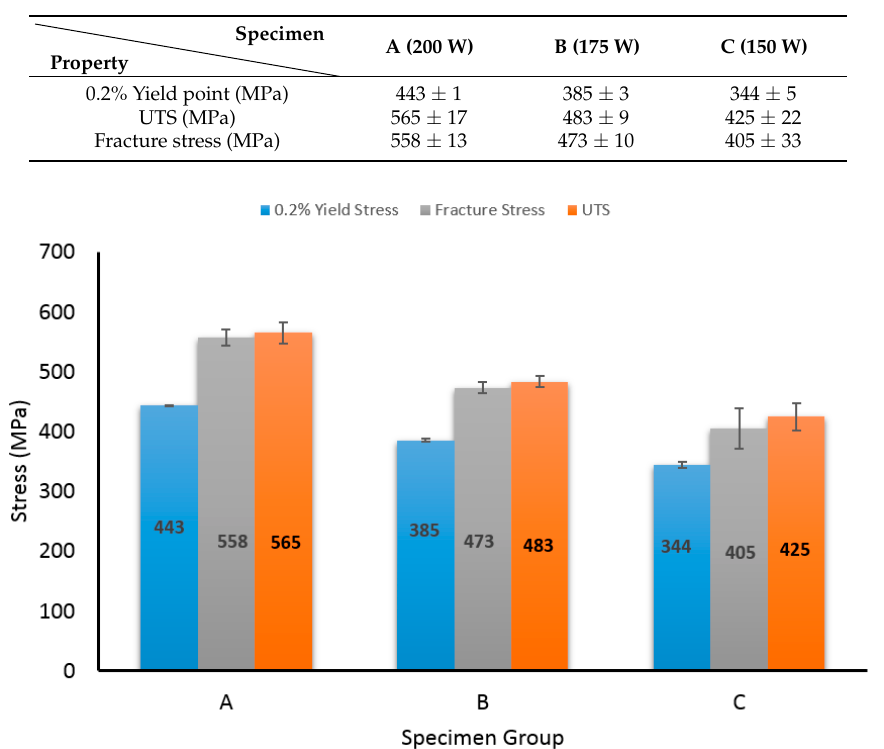
Figure 8. Comparison of mean mechanical properties between samples ( A ) (200 W); ( B ) (175 W); ( C ) (150 W).